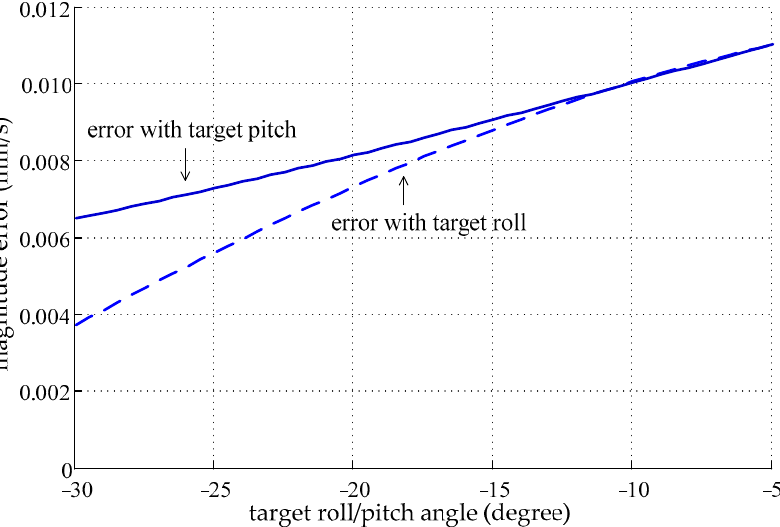
Figure 9. Magnitude error of the maximum deviation of the IMLV with the target roll and pitch angles.